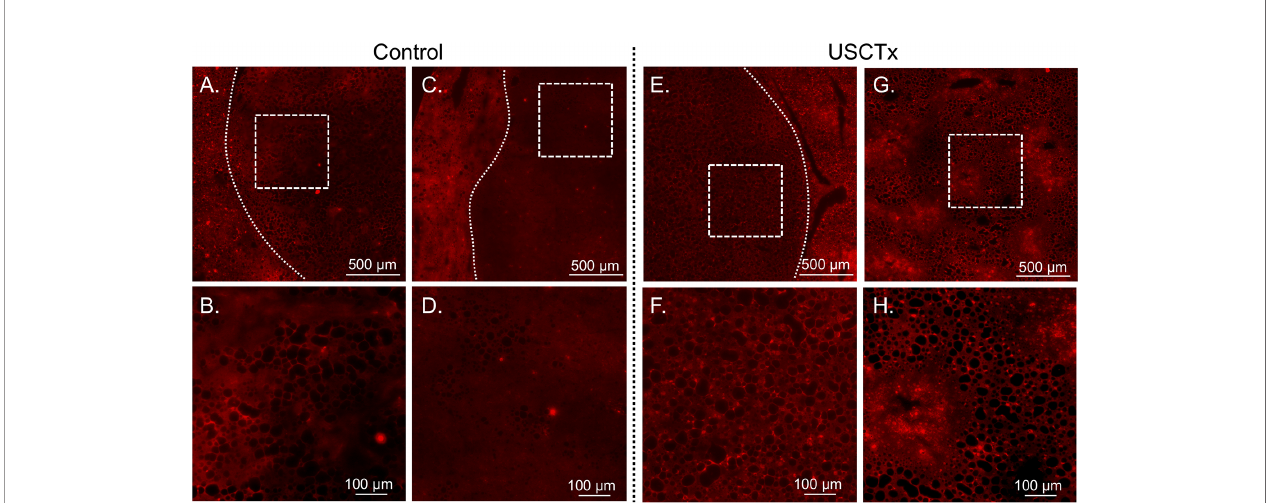
FIGURE 8 | Representative DOX fl uorescent images may be seen from control animals in (A – D) and USCTx animals in (E – H) . Each column represents a different animal. The top row (A, C, E, G) shows tumor morphology (tumor bounded with dashed line, or the entire image is the central part of the tumor) and the bottom row (B, D, F, H) shows the same area at increased magni fi cation. The USCTx animals have more DOX-positive nuclei than the control animals, as seen in (F, H) as compared to (B, D)